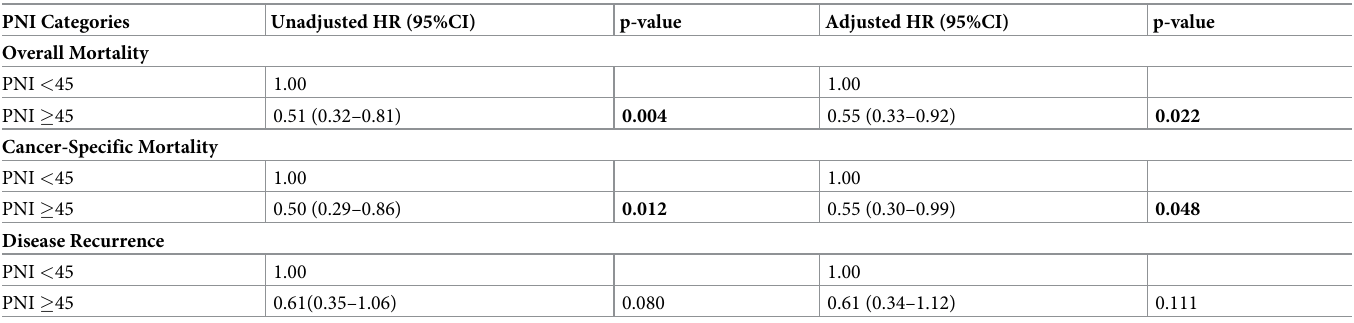
Table 3. Cox regression analyses of pre-treatment prognostic nutritional index (PNI) and endometrial cancer survival outcomes with crude and adjusted hazard ratios and 95% confidence intervals. PNI